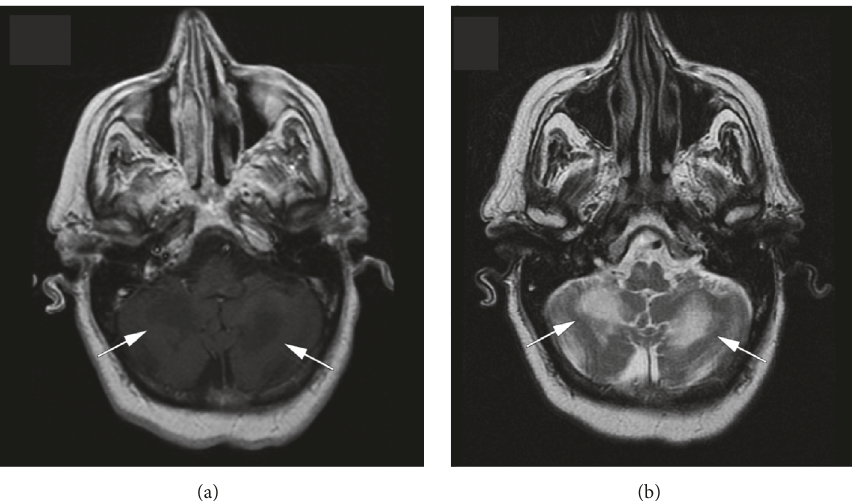
Figure 1: While the brain parenchyma was normal, the MRI shows asymmetric hypointense lesions in both cerebellar hemispheres on T1- weighted images (Slide (a)) and hyperintense lesions on T2-weighted images (Slide